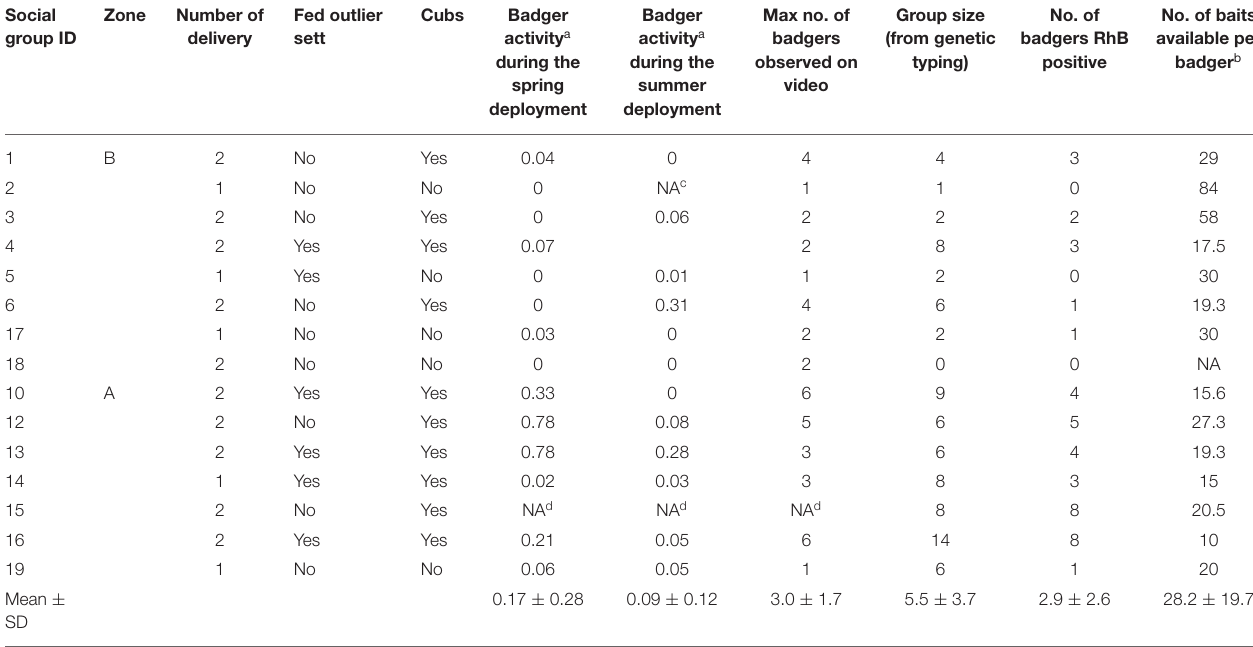
TABLE 2 | Ecological and baits delivery characteristics for each social group. Social Zone Number of group ID delivery